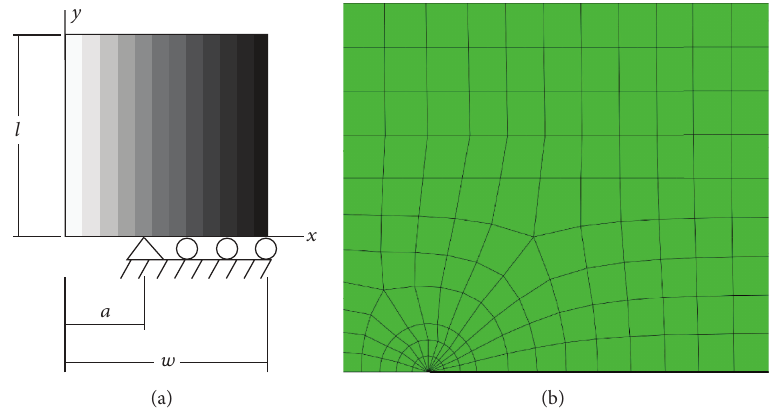
Figure 6: A model of the cracked plate.